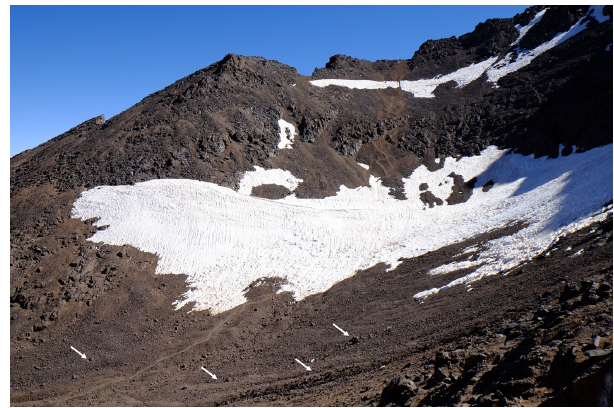
Figure 13. The Irhzer Ikhibi south valley, where the data logger Toubkal 3 was installed. The white arrows indicate arcuate boulder ridges and furrows in the talus slope. Note the large snow patch at the base of the scarp slope.